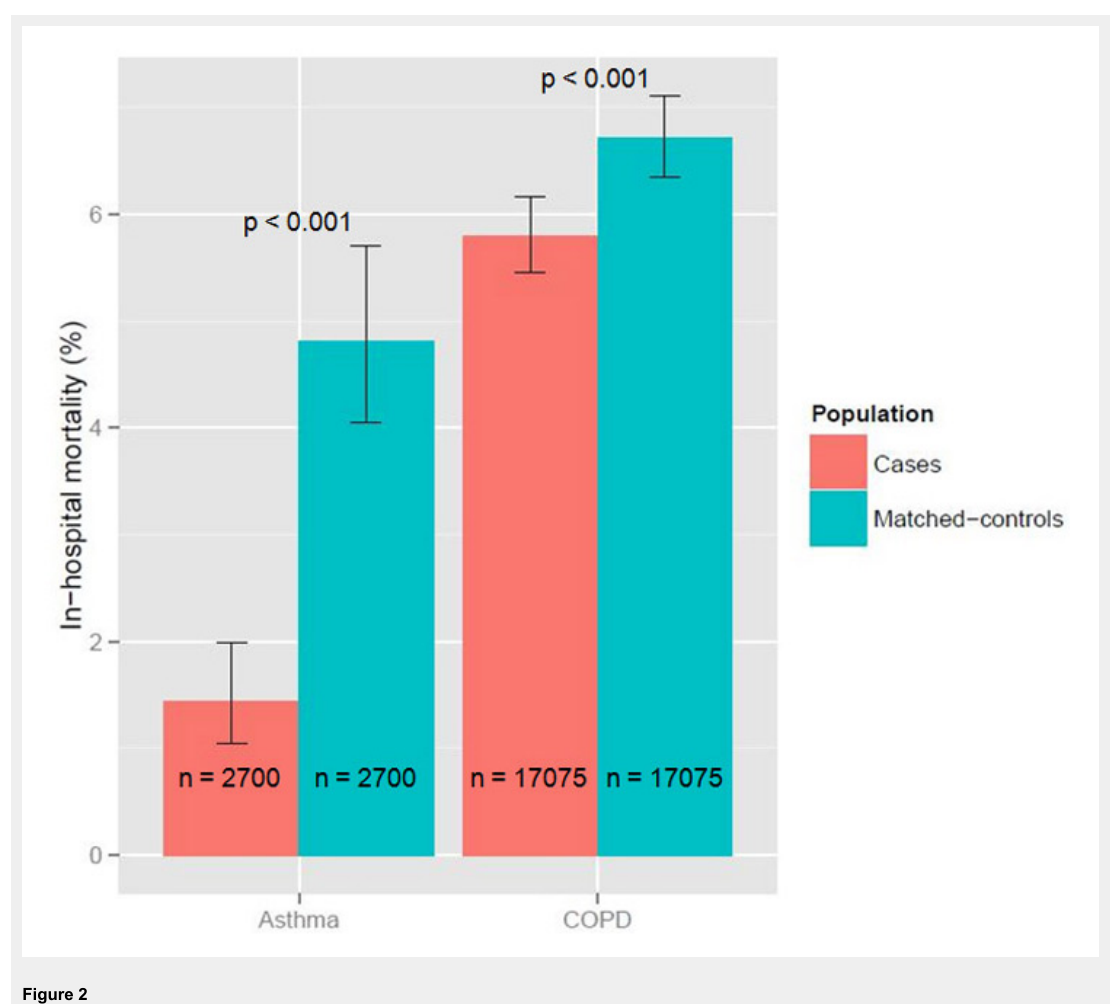
Figure 2 In-hospital mortality of hospitalised COPD and asthma patients compared to their matching controls without lung